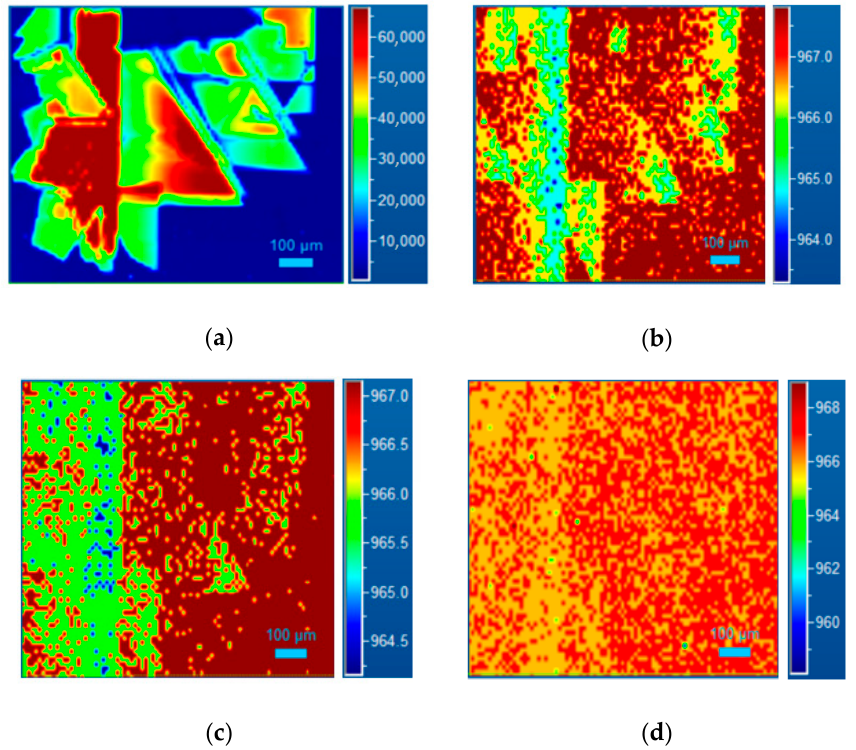
Figure 8. PL map ( a ) and Raman map following LO peak shift for a SF at 2.88 eV (430 nm), at different laser powers: 15 ( b ), 7.5 ( c ) and 3.8 mW ( d )